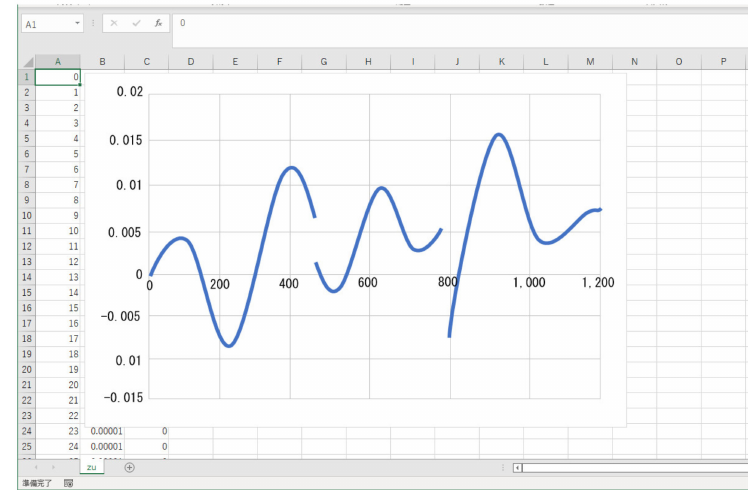
Figure 6. Example of our